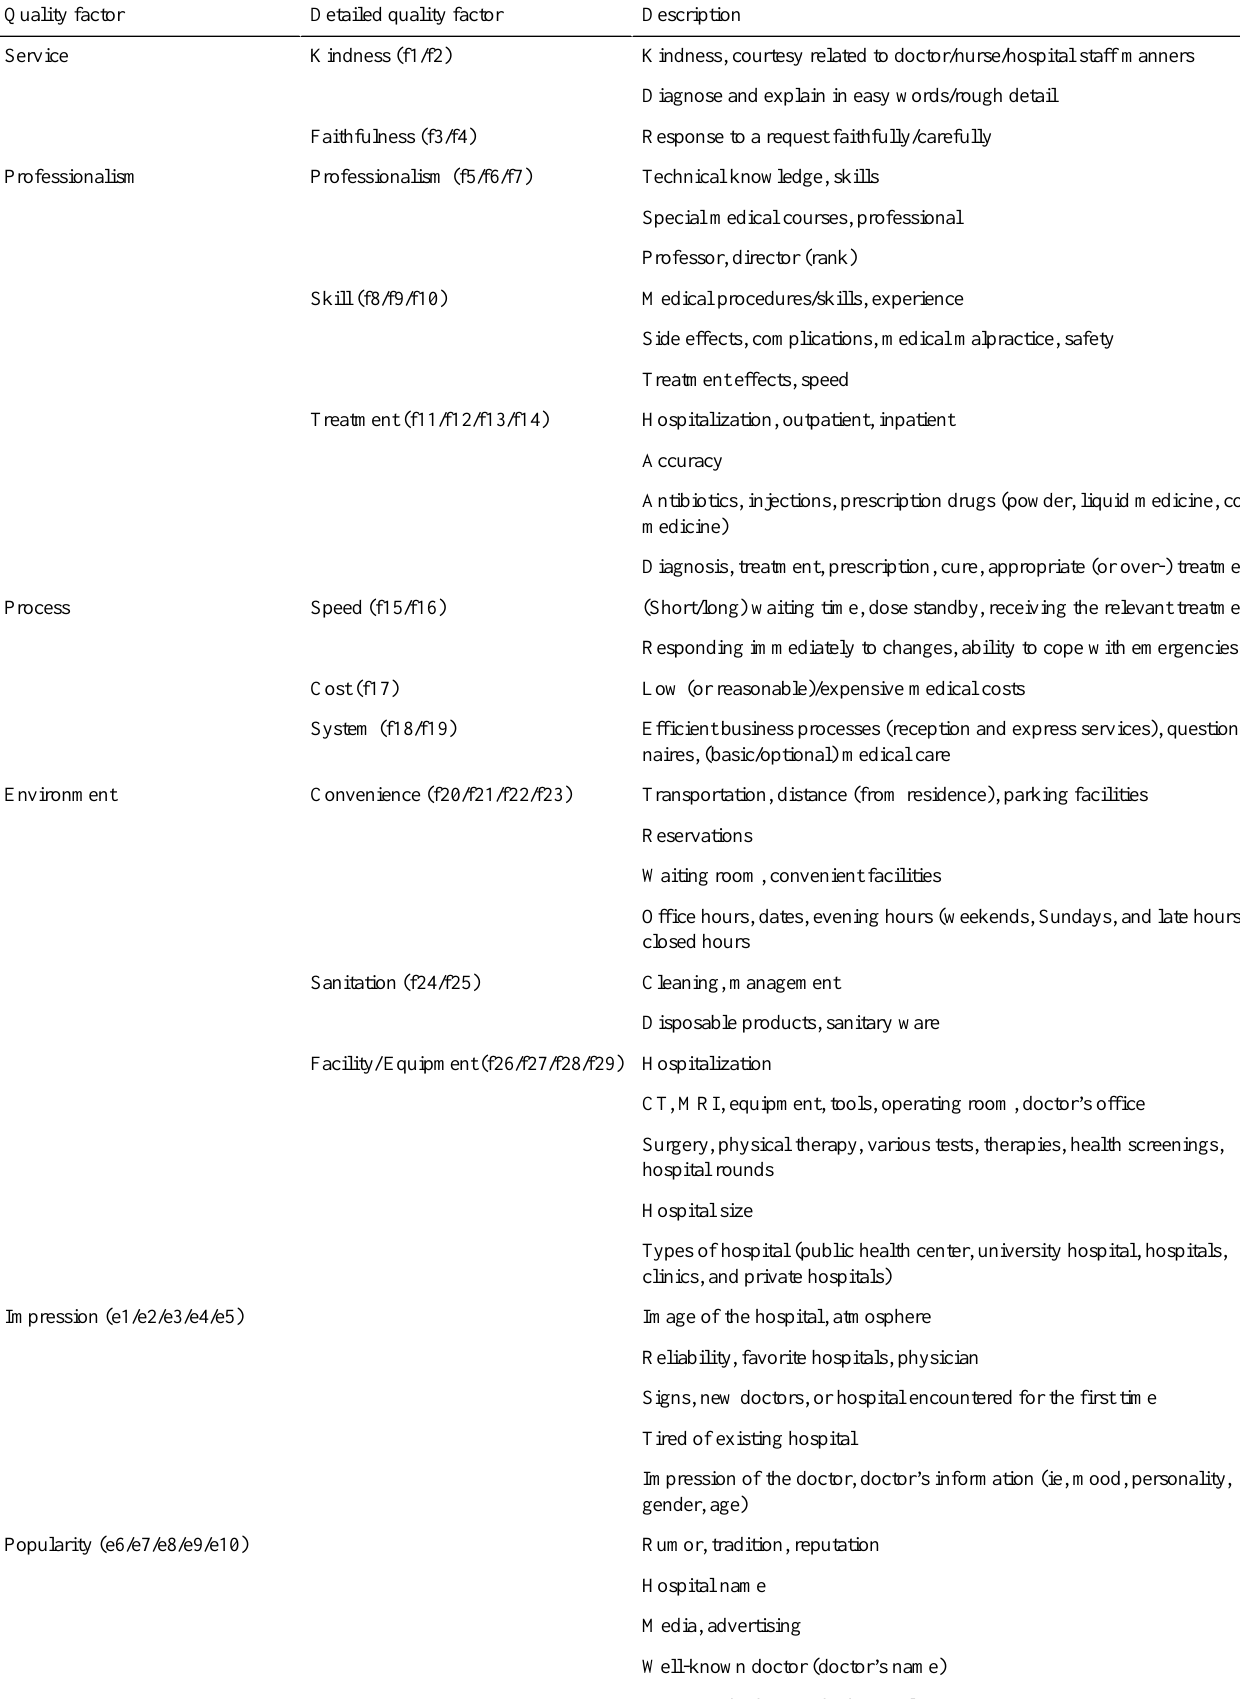
Table 2. Detailed categorizations and subordinate items of social media–based hospital service quality